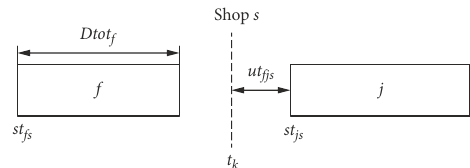
Figure 5. Estimation of the untapped range